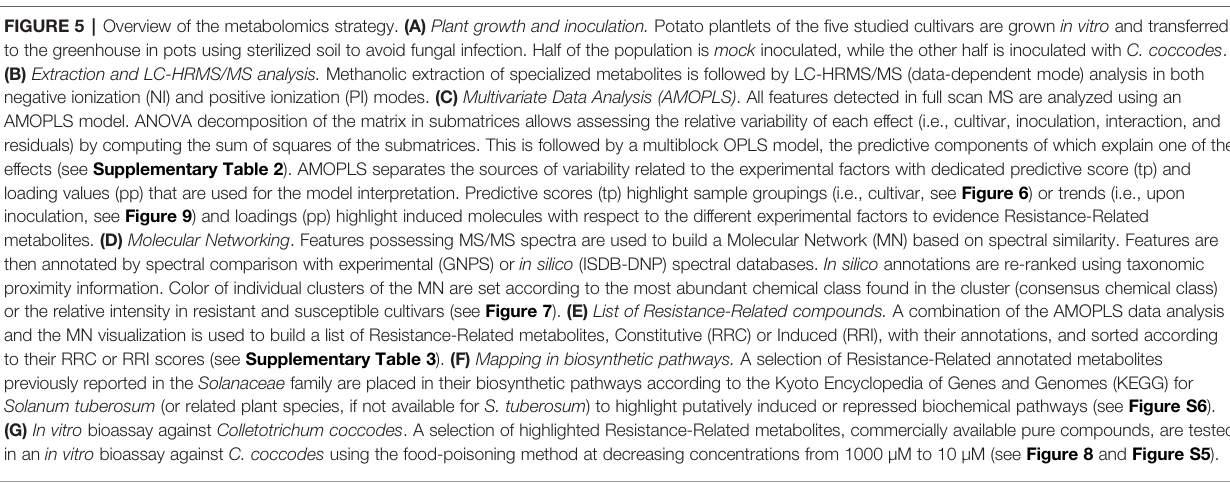
FIGURE 5 | Overview of the metabolomics strategy. (A) Plant growth and inoculation. Potato plantlets of the fi ve studied cultivars are grown in vitro and transferred to the greenhouse in pots using sterilized soil to avoid fungal infection. Half of the population is mock inoculated, while the other half is inoculated with C. coccodes . (B) Extraction and LC-HRMS/MS analysis. Methanolic extraction of specialized metabolites is followed by LC-HRMS/MS (data-dependent mode) analysis in both negative ionization (NI) and positive ionization (PI) modes. (C) Multivariate Data Analysis (AMOPLS) . All features detected in full scan MS are analyzed using an AMOPLS model. ANOVA decomposition of the matrix in submatrices allows assessing the relative variability of each effect (i.e., cultivar, inoculation, interaction, and residuals) by computing the sum of squares of the submatrices. This is followed by a multiblock OPLS model, the predictive components of which explain one of the effects (see Supplementary Table 2 ). AMOPLS separates the sources of variability related to the experimental factors with dedicated predictive score (tp) and loading values (pp) that are used for the model interpretation. Predictive scores (tp) highlight sample groupings (i.e., cultivar, see Figure 6 ) or trends (i.e., upon inoculation, see Figure 9 ) and loadings (pp) highlight induced molecules with respect to the different experimental factors to evidence Resistance-Related metabolites. (D) Molecular Networking . Features possessing MS/MS spectra are used to build a Molecular Network (MN) based on spectral similarity. Features are then annotated by spectral comparison with experimental (GNPS) or in silico (ISDB-DNP) spectral databases. In silico annotations are re-ranked using taxonomic proximity information. Color of individual clusters of the MN are set according to the most abundant chemical class found in the cluster (consensus chemical class) or the relative intensity in resistant and susceptible cultivars (see Figure 7 ). (E) List of Resistance-Related compounds. A combination of the AMOPLS data analysis and the MN visualization is used to build a list of Resistance-Related metabolites, Constitutive (RRC) or Induced (RRI), with their annotations, and sorted according to their RRC or RRI scores (see Supplementary Table 3 ). (F) Mapping in biosynthetic pathways. A selection of Resistance-Related annotated metabolites previously reported in the Solanaceae family are placed in their biosynthetic pathways according to the Kyoto Encyclopedia of Genes and Genomes (KEGG) for